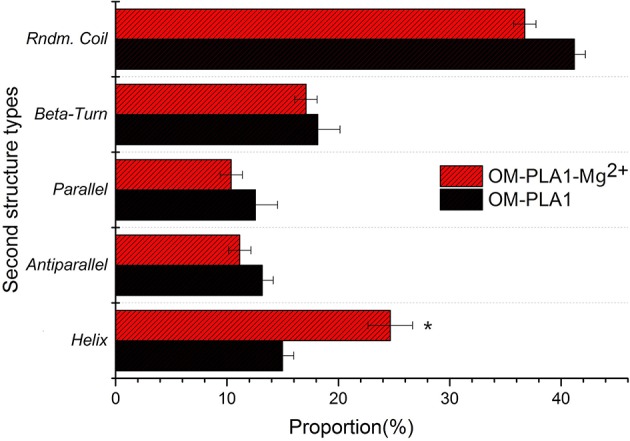
Secondary structures and proportions of OM-PLA1 and OM-PLA1-Mg2+ analyzed by CDPro software.